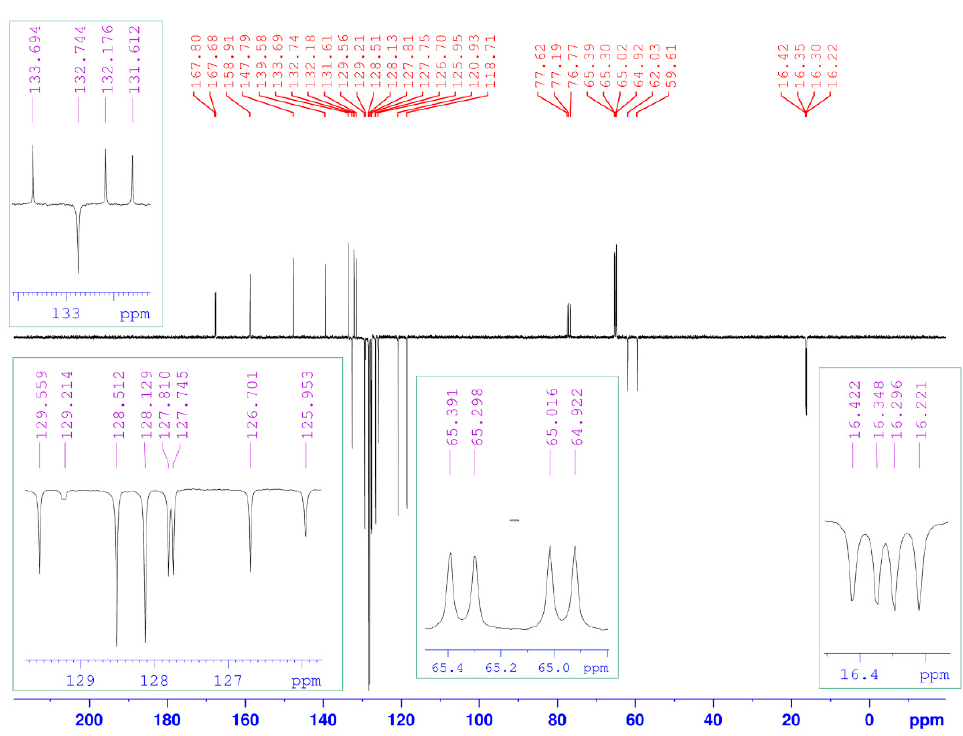
Figure 2. 1 H-NMR spectrum of cycloadduct ( 3 ).